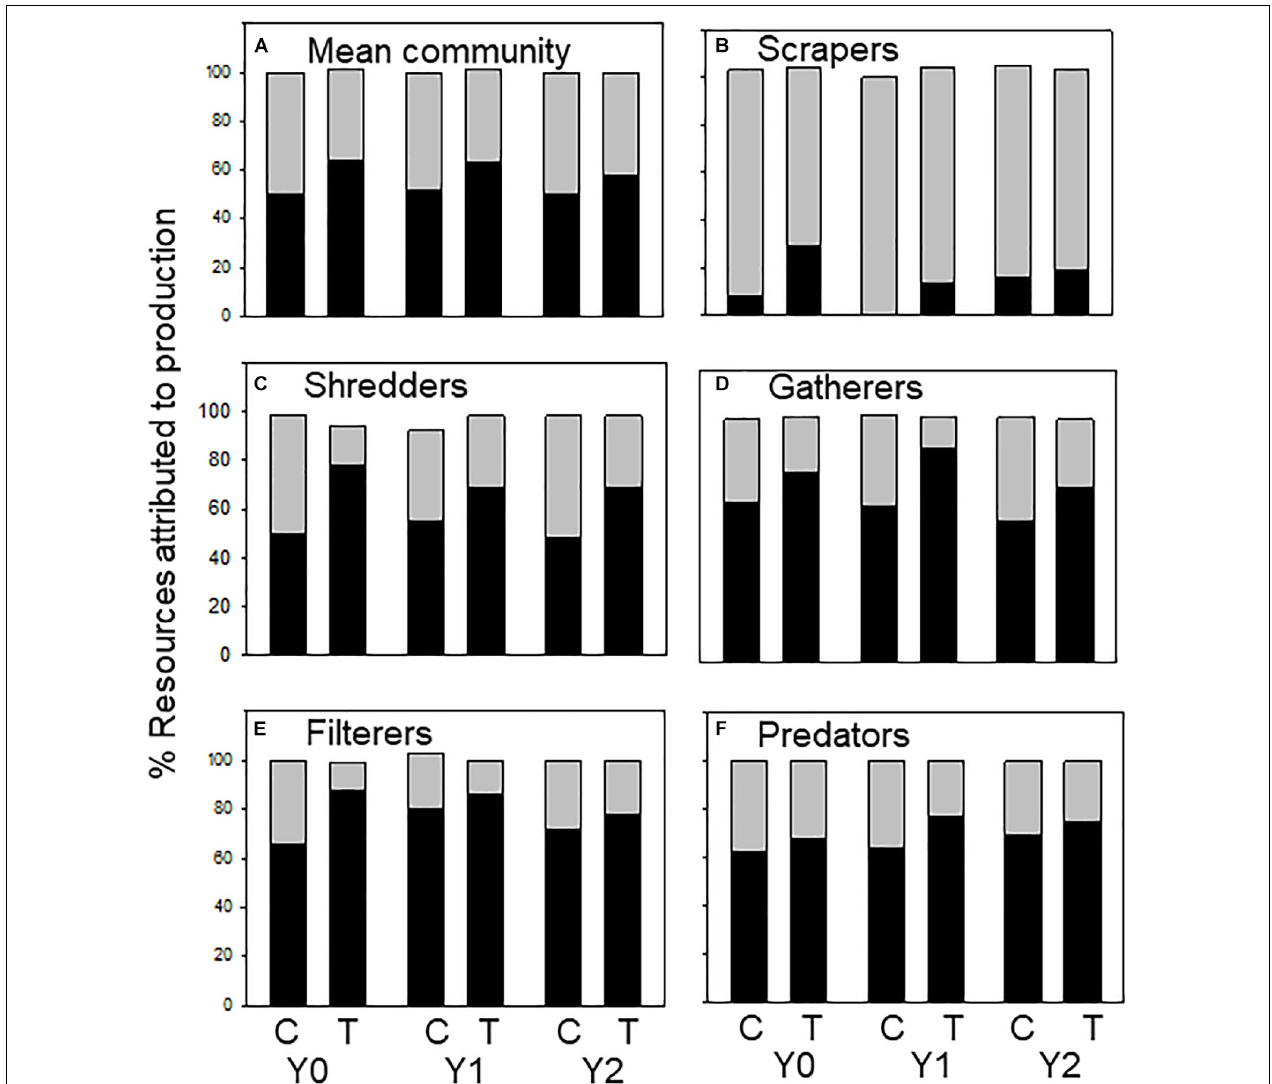
FIGURE 3 | Percent allochthonous (dark bars) and autochthonous (light bars) C contributing to macroinvertebrate secondary production (categorized by functional feeding groups) in an upstream control C and downstream wood-added reach (treatment, T) 1 year before (Y0) and 1 (Y1) and 2 years (Y2) after wood addition. Values may not equal 100% because percentages were averaged across taxa within functional feeding groups (FFGs). (A) % resources attributed to total macroinvertebrate production, (B) % resources attributed to scraper production, (C) % resources attributed to shredder production, (D) % resources attributed to gatherer production, (E) % resources attributed to filterer production, and (F) % resources attributed to predator